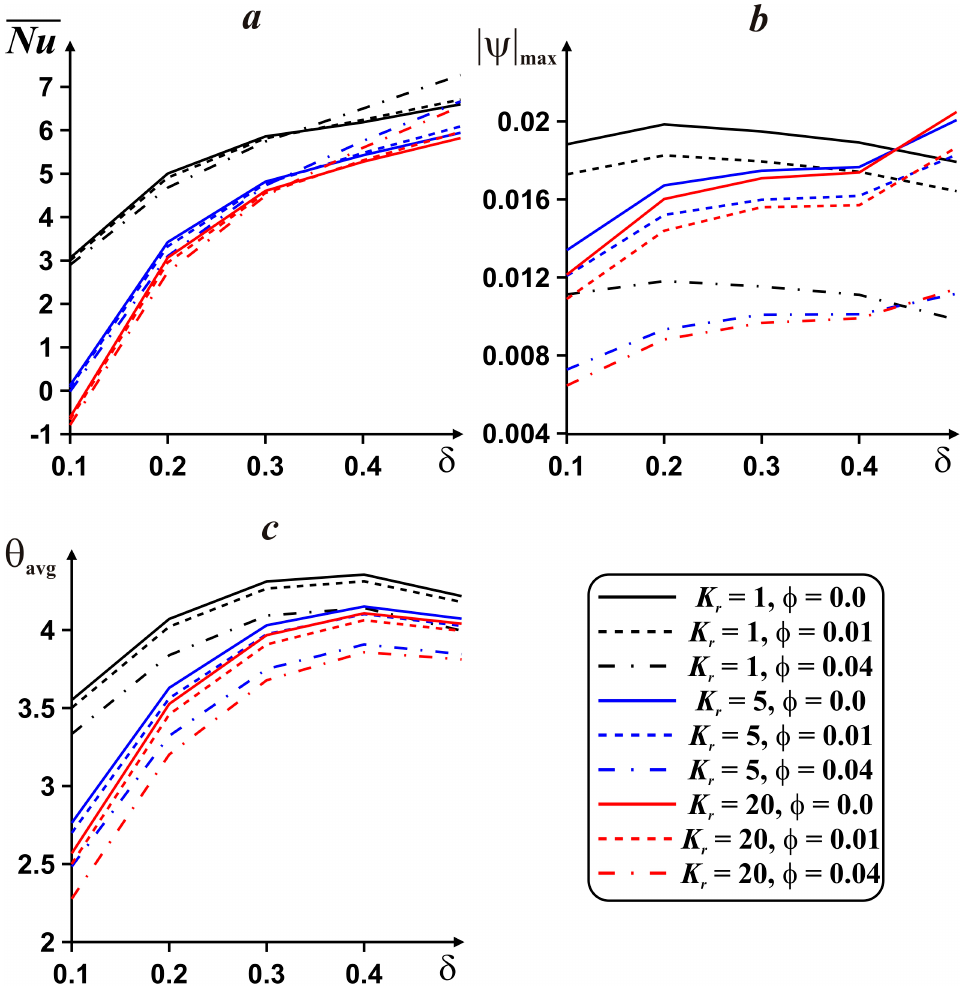
Figure 10. Dependences of the average Nusselt number ( a ), nanoliquid circulation rate ( b ) and mean heater temperature ( c ) on the heater location, thermal conductivity ratio and nanoparticles concentration for Ra = 10 3 .